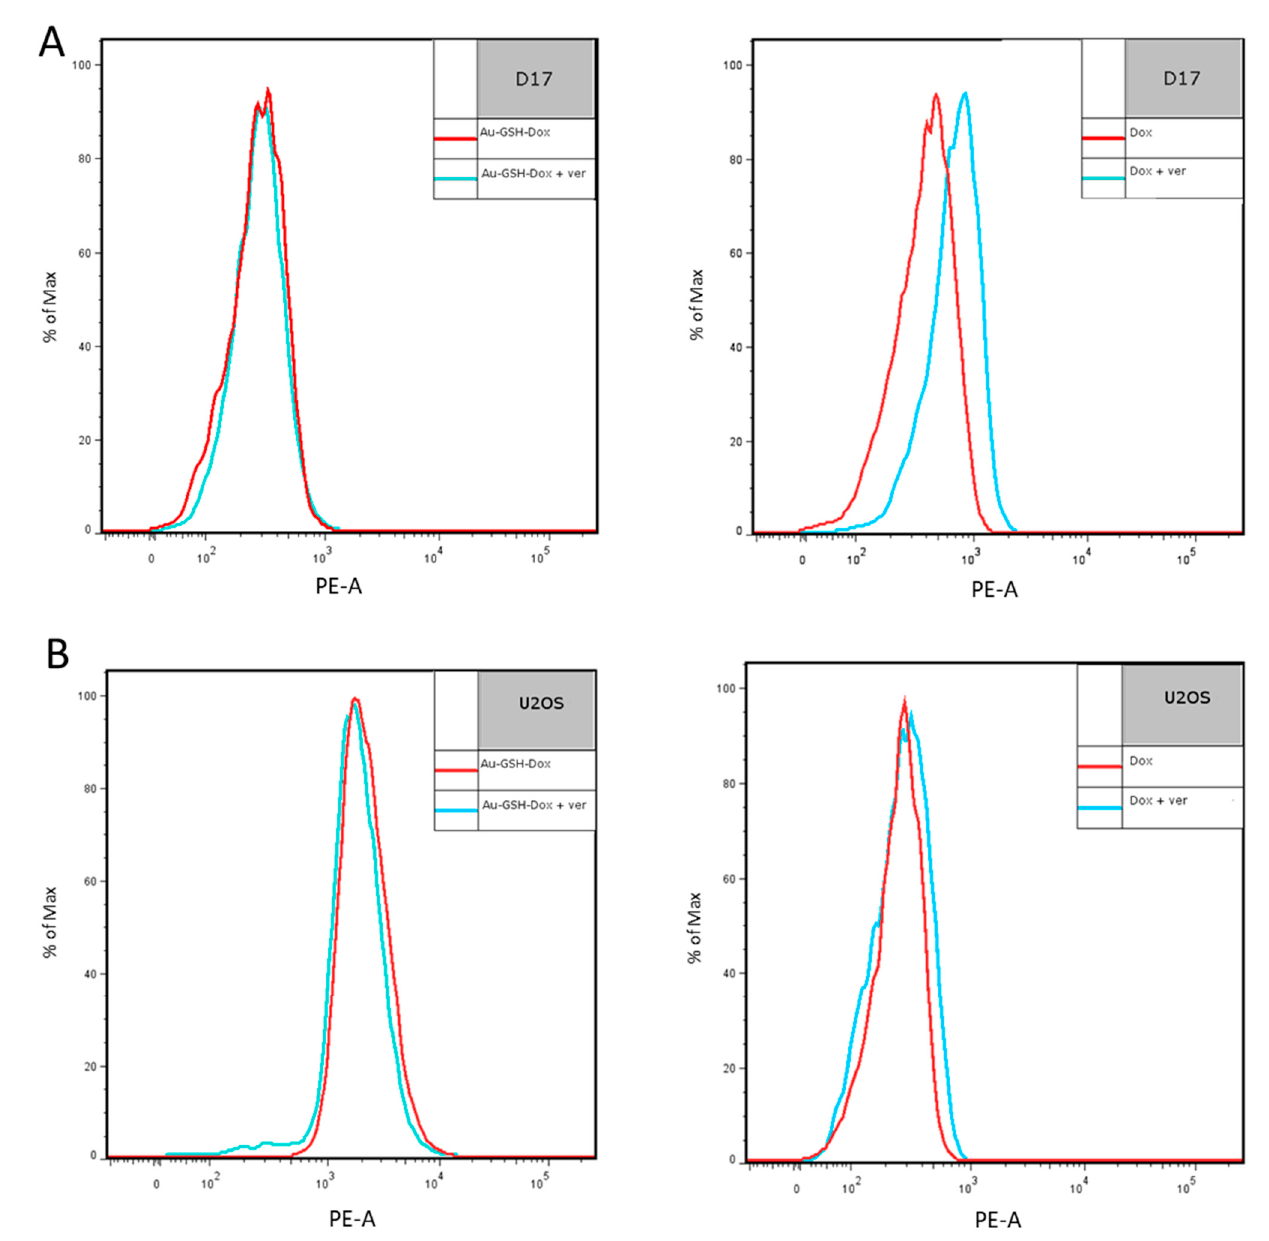
Figure 7. Fluorescence of D17(A) and U2OS (B) after treatment with Au-GSH-Dox or Dox alone with or without verapamil, analyzed by flow cytometry.